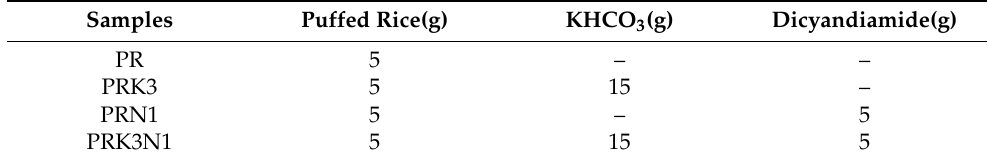
Table 1. A detailed recipe of all